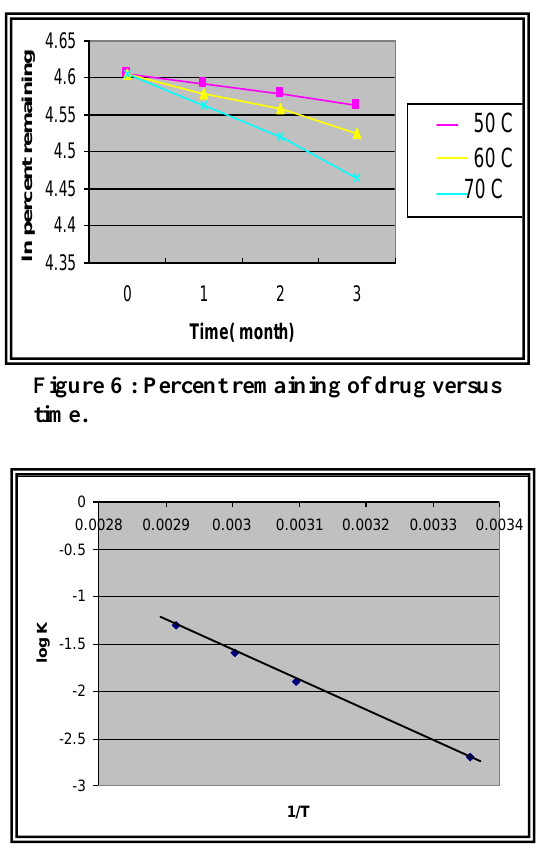
Fig7: Arrhinous plot for expiration date estimation of nicotine tablet (Formula